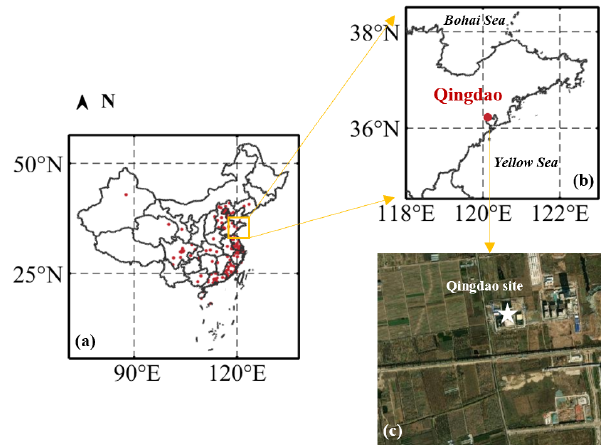
Figure 1. (a, b) Geographical distribution and (c) surface type of the radar wind profiler station at Qingdao. The surface type photo is provided by Google Earth (© Google